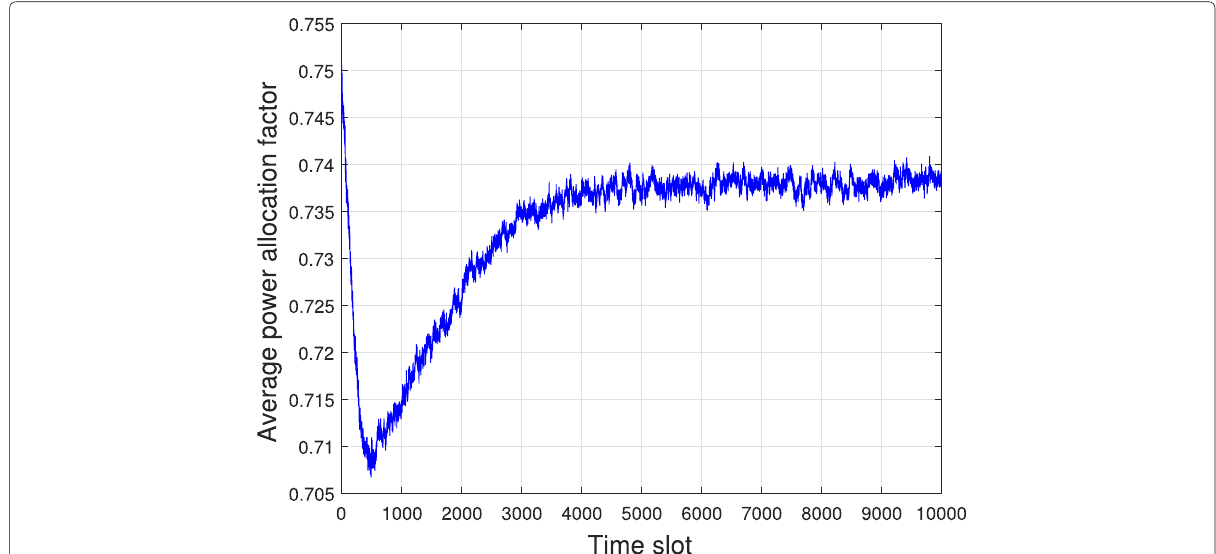
Fig. 4 The average power allocation factor of the power allocation